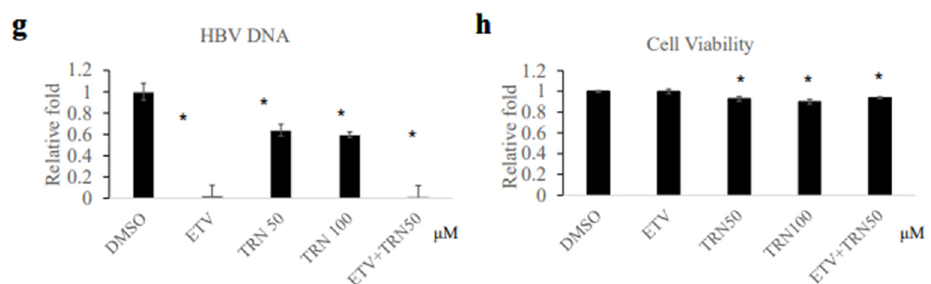
Figure 3. Effect of tranilast on HBV infection in human hepatocytes. ( a – d ) Human hepatocytes, PXB cells were infected with HBV and treated with the compound at the indicated concentration. At day 7, HBV DNA in the medium, HBsAg in the medium, intracellular HBV RNA level, and intracellular cccDNA level were measured. Experiments were performed in duplicate. ( e ) Cell viability on day 7 was determined by cell proliferation assay. Data were expressed as mean and standard deviation ( n = 4). ( f , g ) and PXB cells were infected with HBV and cultured. On day 14, the indicated concentration of tranilast or entecavir (0.1 μ M) was added for 7 days. Note that the peak plasma concentration of entecavir is 0.02–0.04 μ M in the clinical setting [22]. On day 21, the HBsAg level and HBV DNA